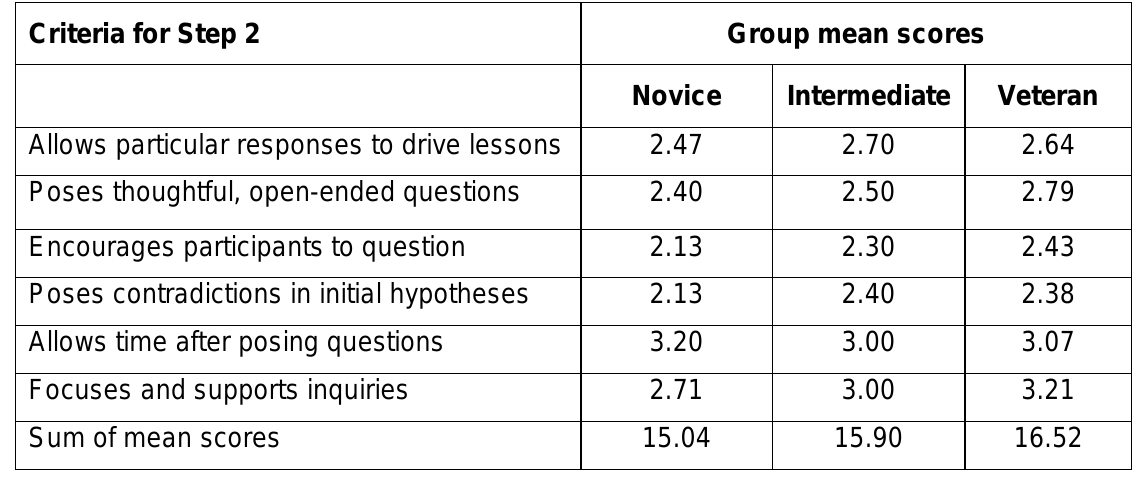
Comparison of facilitator mean scores, across facilitator categories, on their ability to allow participants to explore